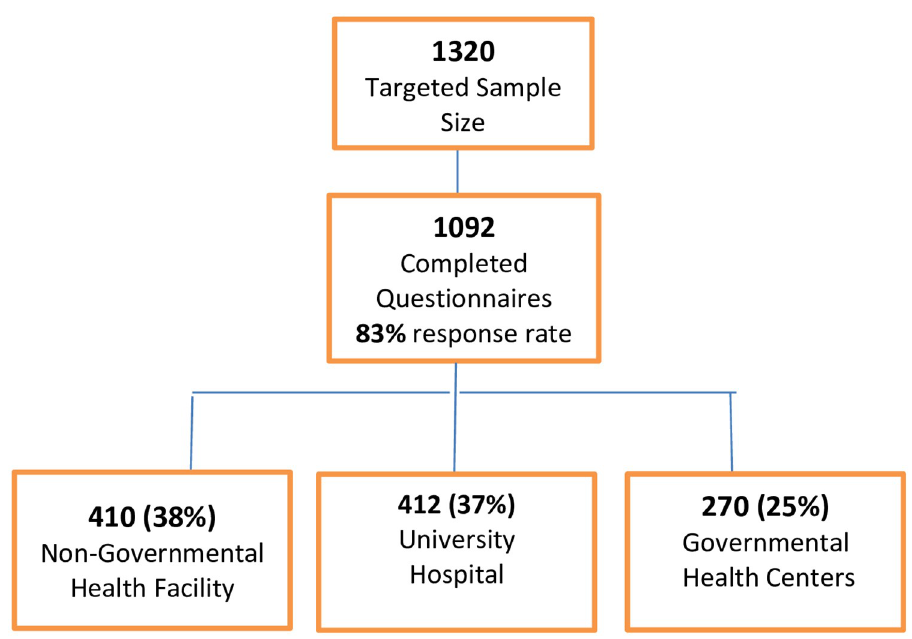
Fig 1. Response rate of the participants and their distribution among the study